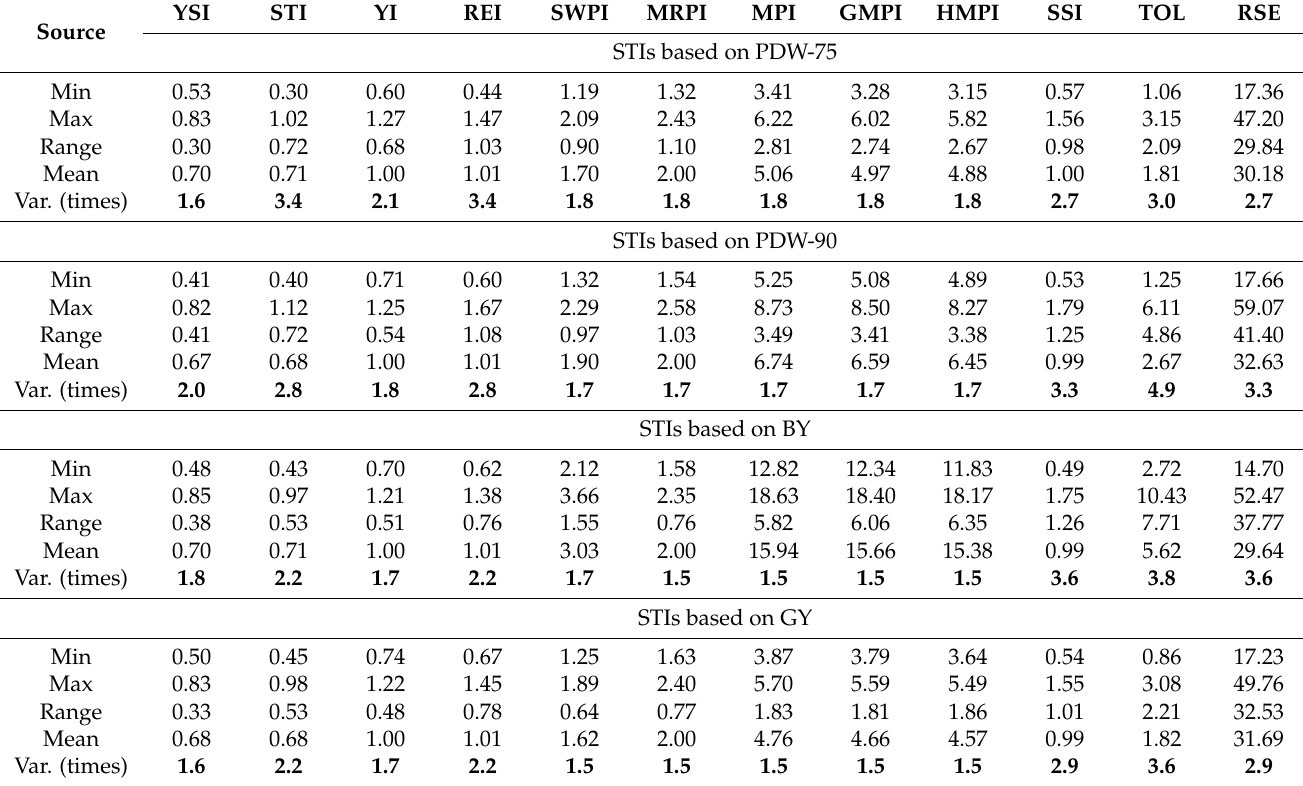
Table 4. Destructive statistics ((minimum (Min), maximum (Max), range, mean values, and variation between Max and Min values (Var.)) of the different stress tolerance indices (STIs) calculated based on plant dry weight measured at 75 (PDW-75) and 90 (PDW-90) days after sowing, biological yield (BY), and grain yield (GY) of 64 wheat genotypes. Data are the average of two years and three replications ( n =